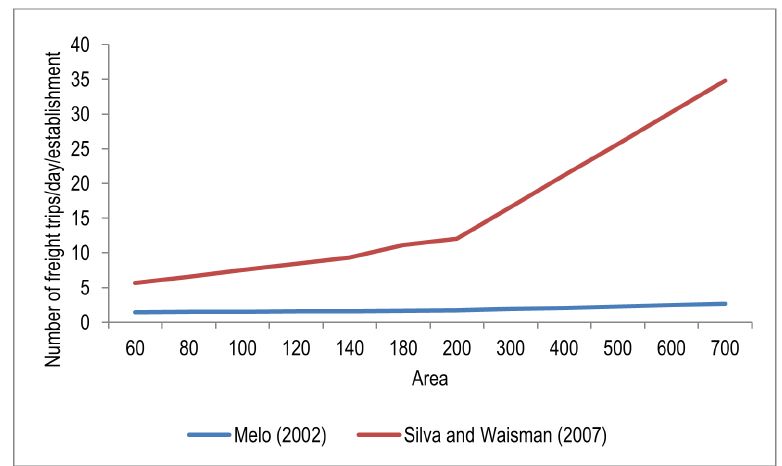
Figure 1: Graphical representation of Brazilian models to pubs and restaurants considering area as variable